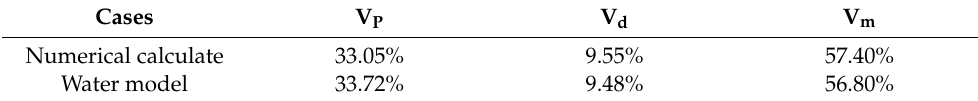
Figure 2. RTD curve in the tundish for water model and numerical simulation. Table 5. Fluid flow characteristics in the tundish for water model and numerical